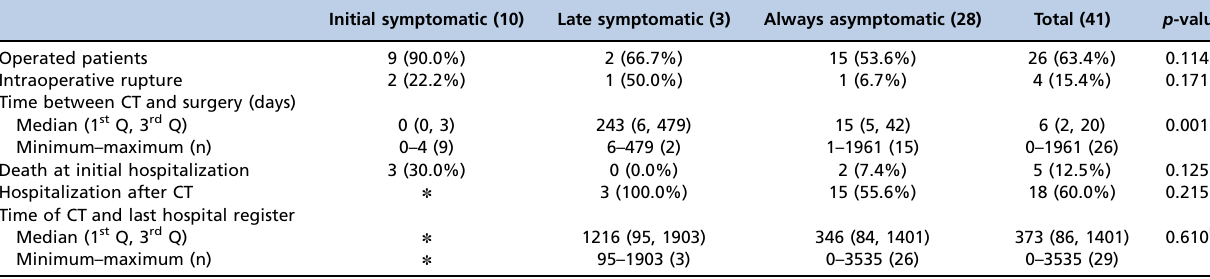
Table 4 - Surgical characteristics, time, and deaths by group.